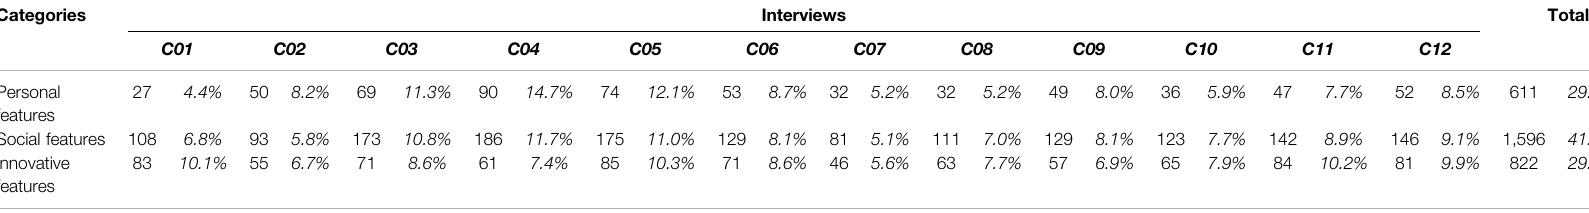
TABLE 3 | Global quotes of Social Entrepreneurship Competency.